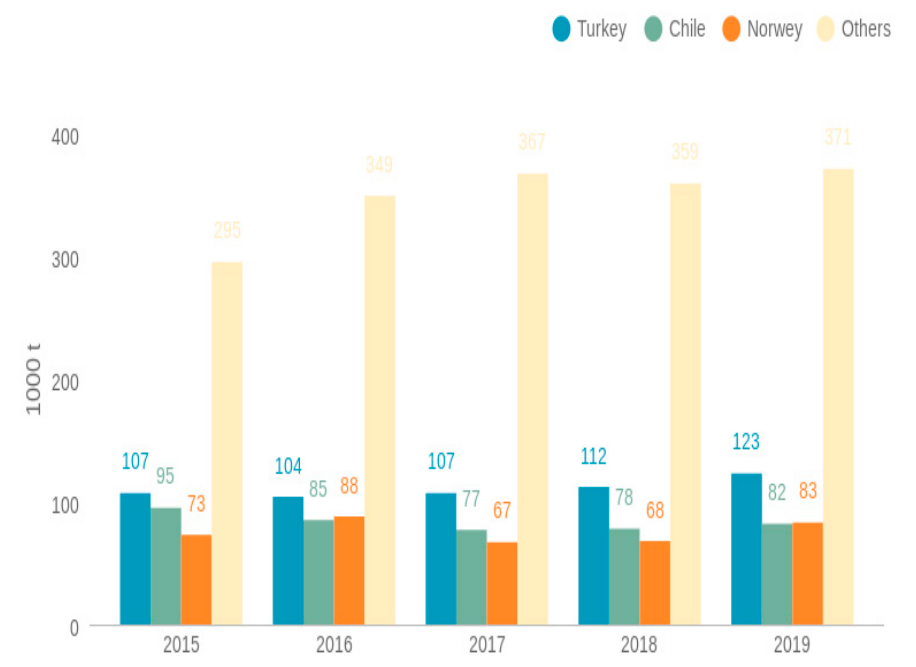
Figure 1. Major producers of rainbow trout worldwide ( × 1000 t). Source: FAO, 2022 [1]. Table 3. Main exporting and importing nations of aquaculture products in 2020.